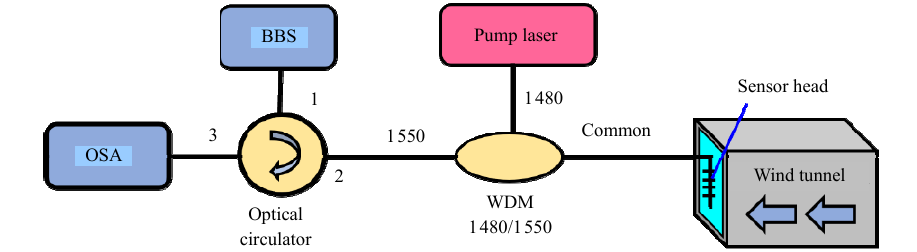
Fig. 2 Experimental